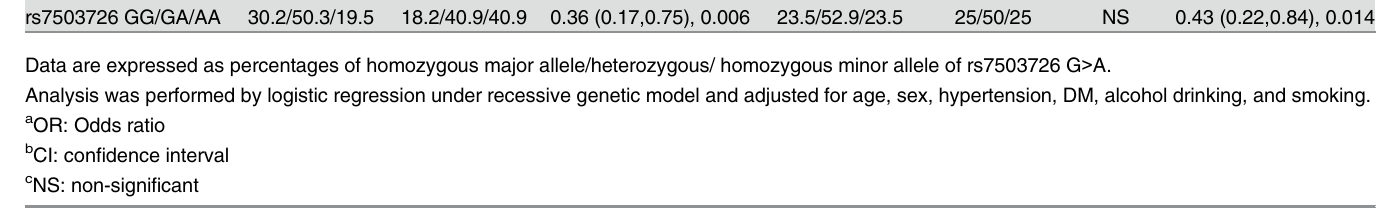
Table 4. Differences in hemorrhage size as a function of the presence or absence of MMP-2 and TIMP-2 minor allele in patients with spontaneous deep intracerebral hemorrhage.